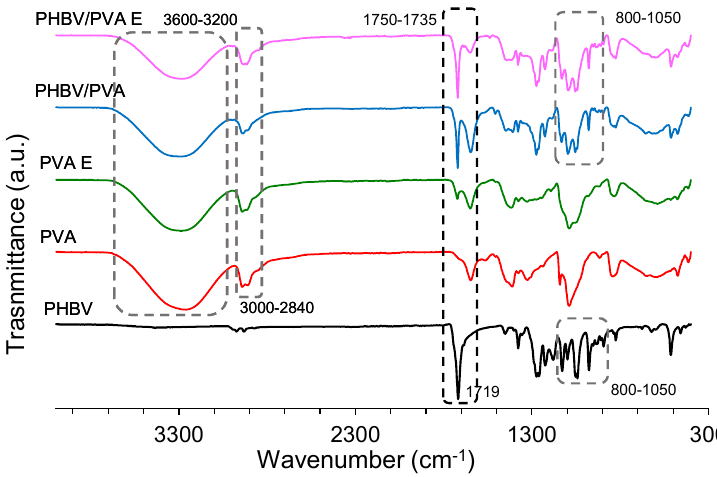
Figure 3. Fourier transform infrared spectroscopy (FTIR) spectra in the region of 4000–300 cm −1 . PHBV, PVA, PHBV/PVA, PVA E and semi-IPN PHBV/PVA E.